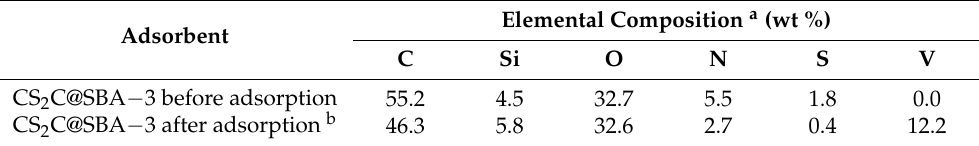
Table 3. Elemental composition of CS 2 C@SBA − 3 before adsorption and after adsorption. Adsorbent